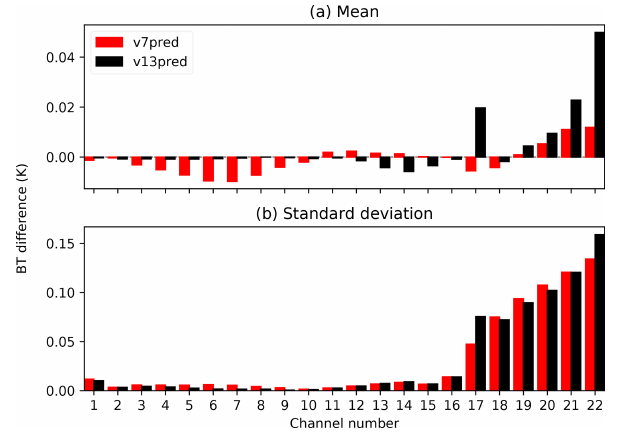
Figure 9. RTTOV vs. brightness temperatures calculated from channel-integrated LBL transmittances for ATMS v7 and v13 pre- dictors for 25000 independent profiles.